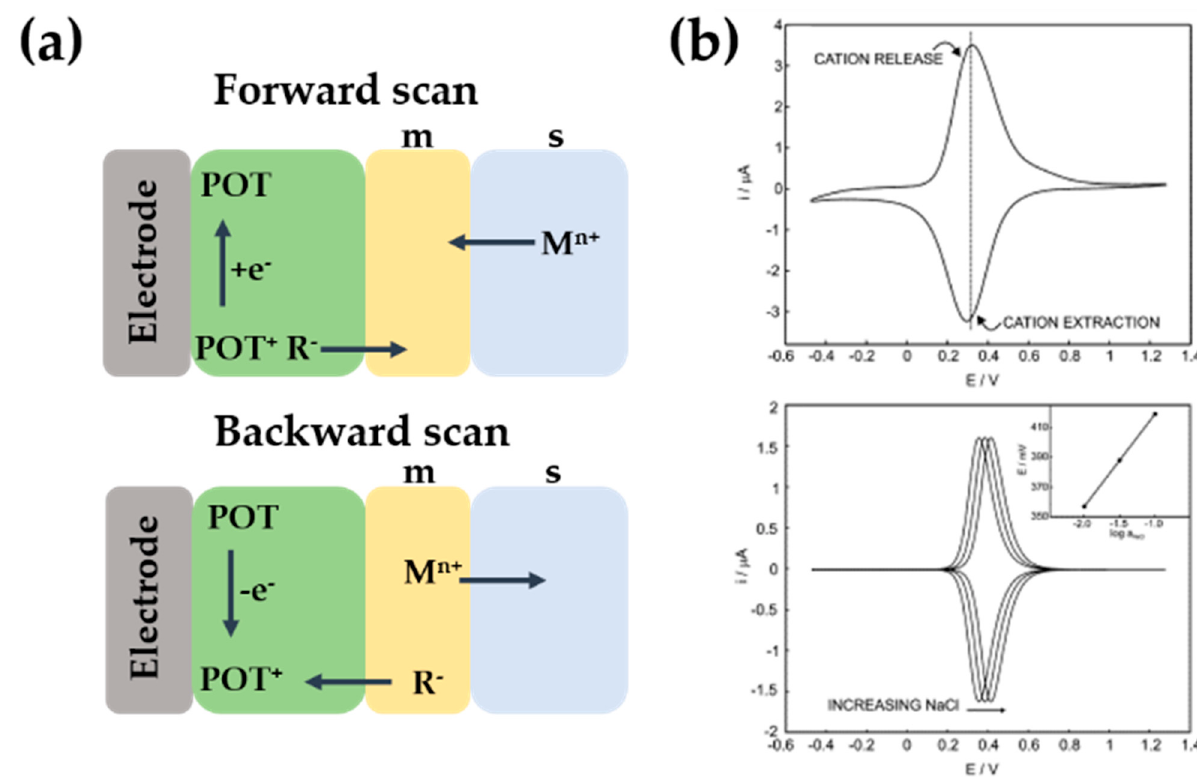
Figure 3. ( a ) Proposed response mechanism of a cation exchanger (R − )-based thin layer membrane backside contacted with POT during the forward scan and backward scan. ( b ) Top: Cyclic voltammograms for the cation exchanger-based membrane MII in contact with 10 mM NaCl at a scan rate of 100 mV s − 1 . Bottom: Calculated cyclic voltammograms at three concentration levels of NaCl (scan rate 100 mV s − 1 ); inset, E peak vs. log a Na+ . Adapted from reference [53].